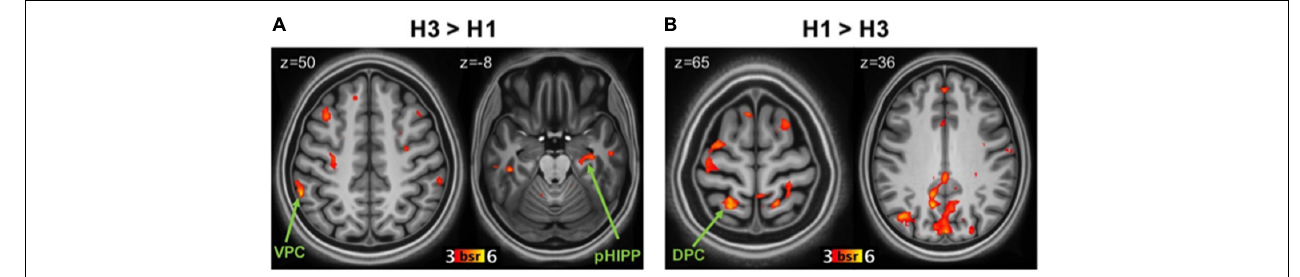
FIGURE 2 | Brain regions related to study repetitions. (A) Regions more active during correct recognition of 3x items (H3) than 1x (H1). Panel (B) : regions more active during H1 than H3. DPC, dorsal parietal cortex; VPC, ventral parietal cortex; pHIPP, posterior hippocampus; BSR, salience/standard error ratio from the bootstrap